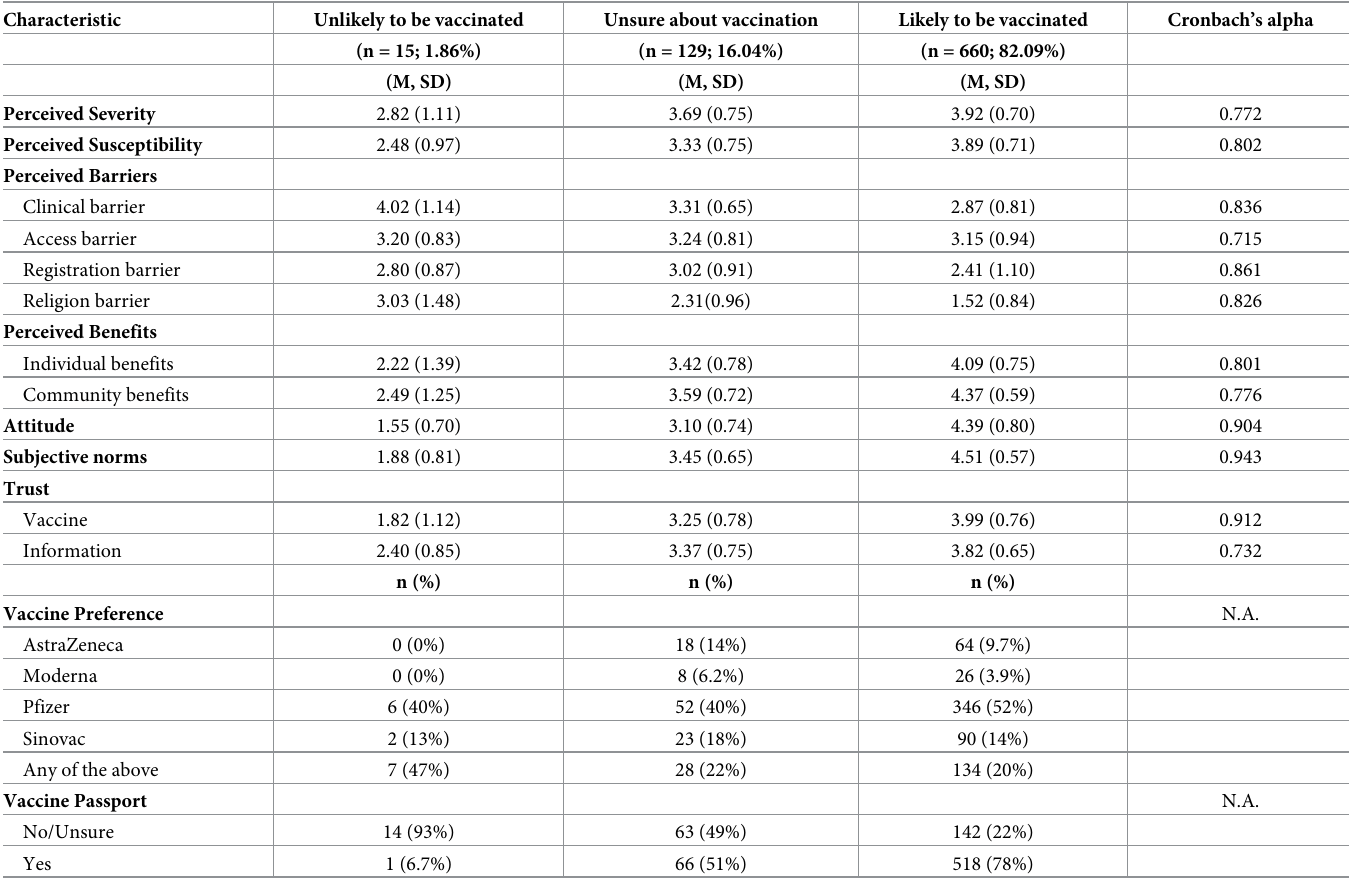
Table 1. Descriptive statistics of all variables in the national sample (N =